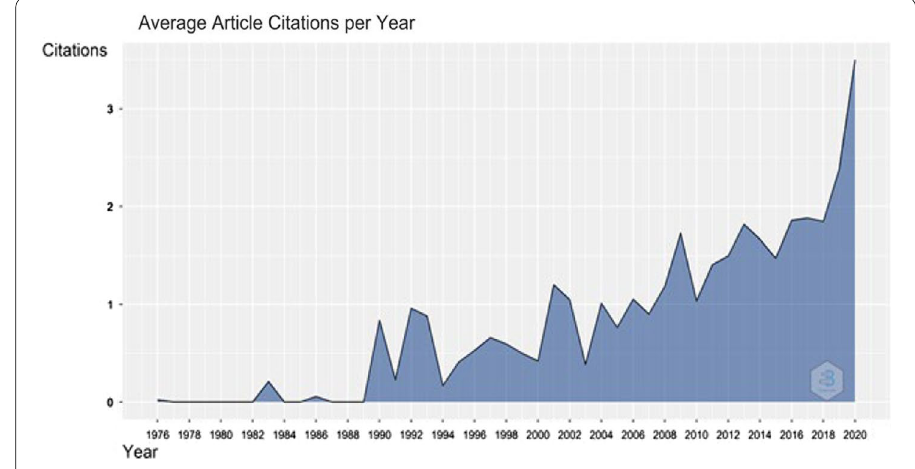
Fig. 4 Average citations per year for the keywords “Shipping